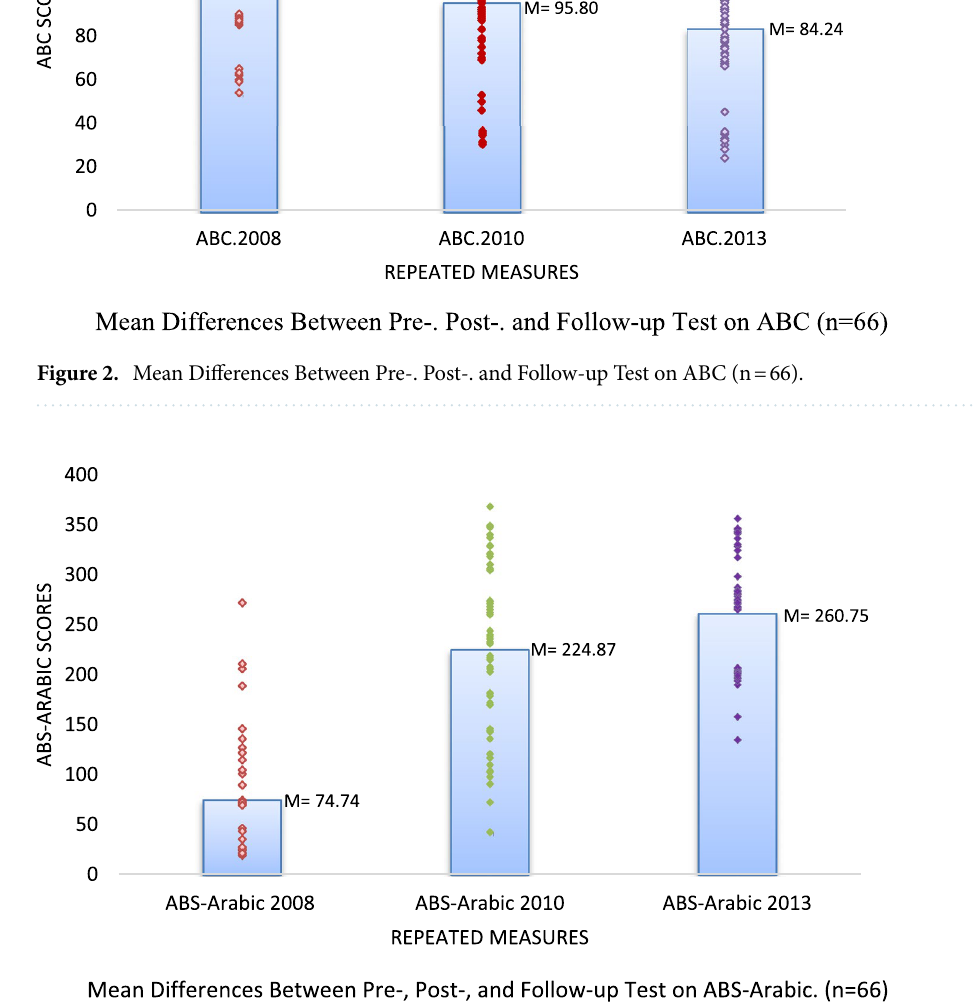
Figure 3. Mean Differences Between Pre-, Post-, and Follow-up Test on ABS. (n =